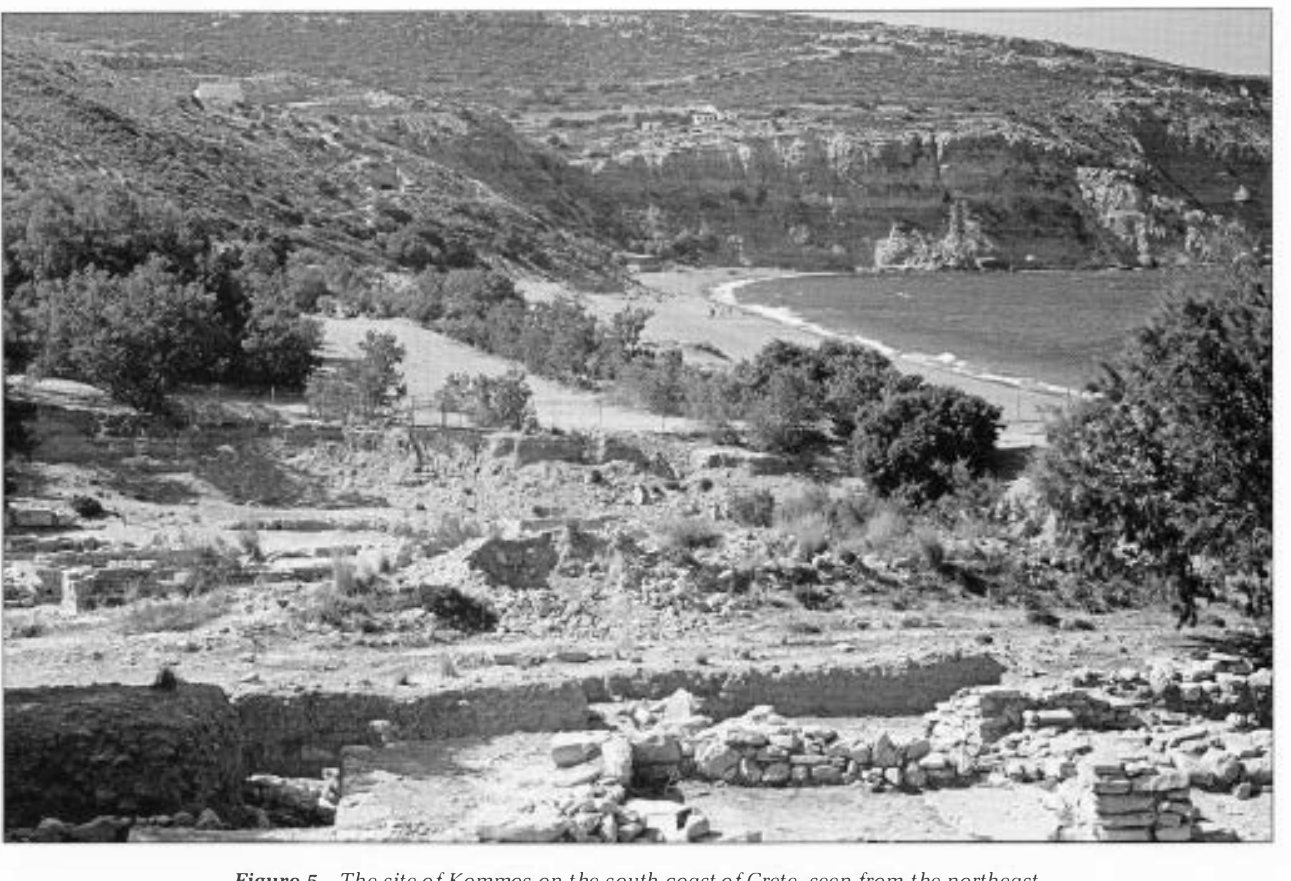
Figure 5 The site of Kommos on the south coast of Crete, seen from the northeast,